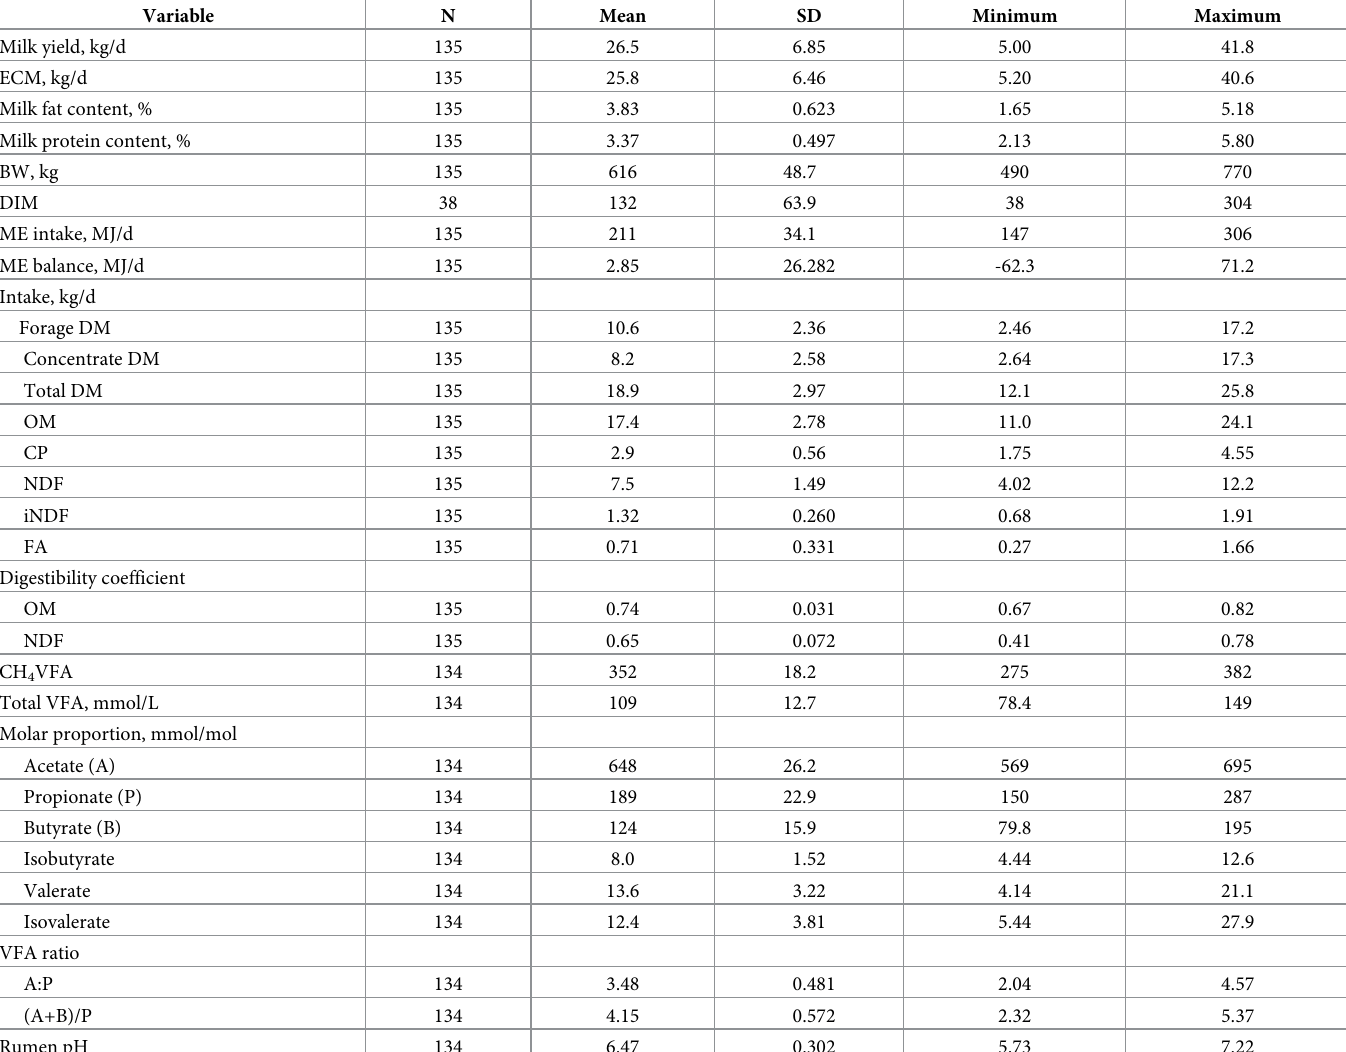
Table 1. Minimum, maximum, mean, and standard deviation values for milk yield, milk composition, energy balance, nutrient intake, rumen fermentation, digest- ibility, and predicted CH 4 in the data